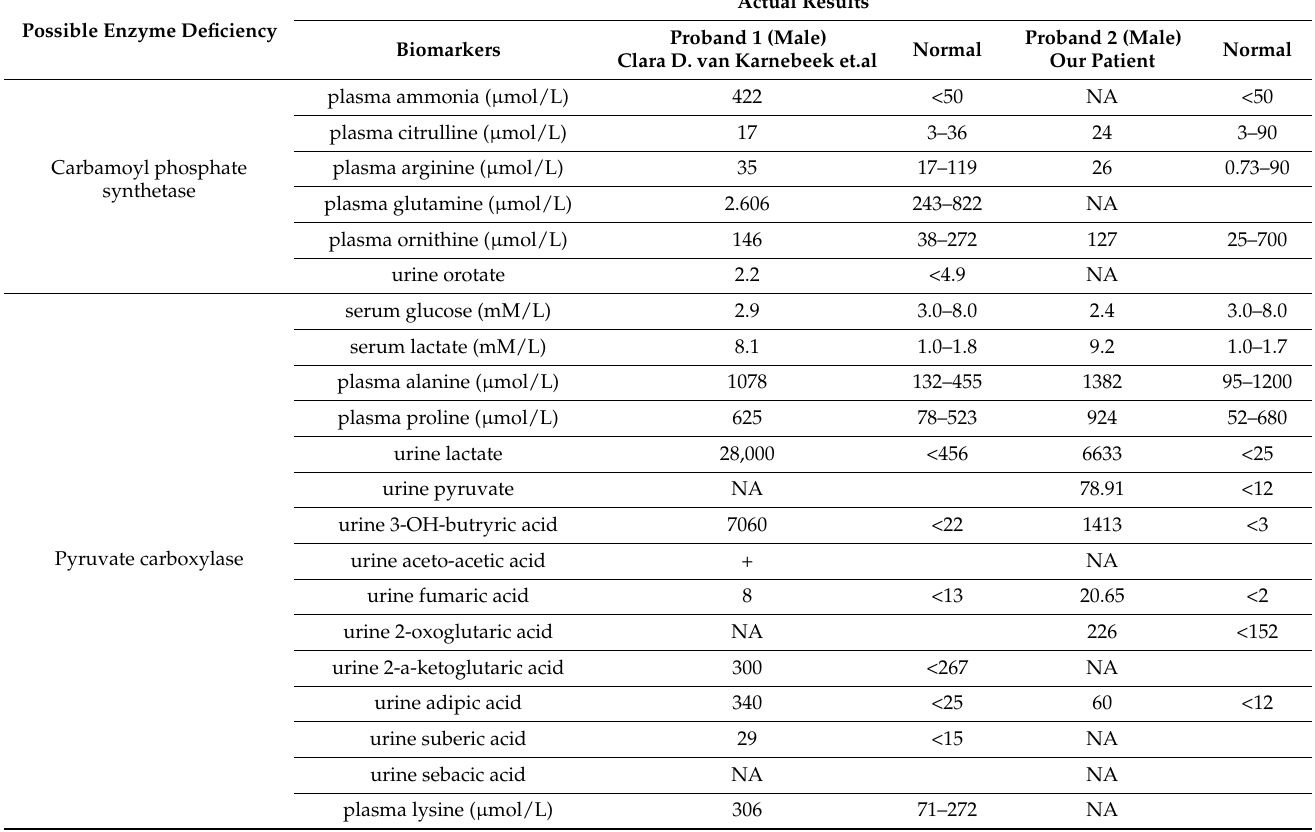
Table 1. Biochemical findings observed in our patient and the previously described patient having the same mutation